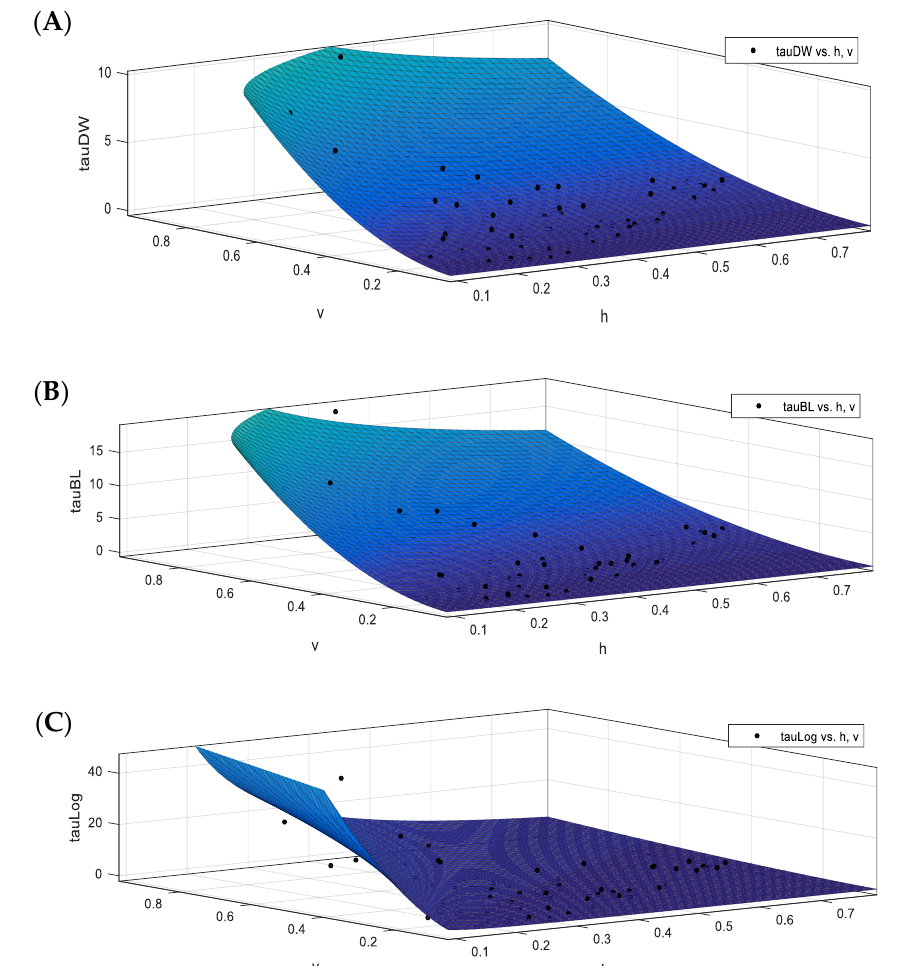
Figure 11. Surface fitted on the data obtained using the methods ( A ) Darcy–Weisbach, ( B ) boundary layer characteristics, ( C ) logarithmic law. Table 7. Calibration results of three – parameter resistance model using three different methods.